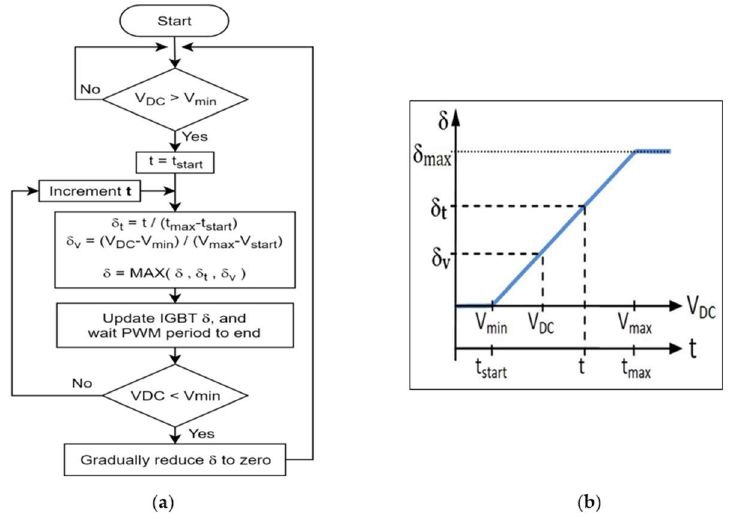
Figure 15. ( a ) Flowchart of the PWM chopper interface, ( b ) response curve according to voltage and time settings.